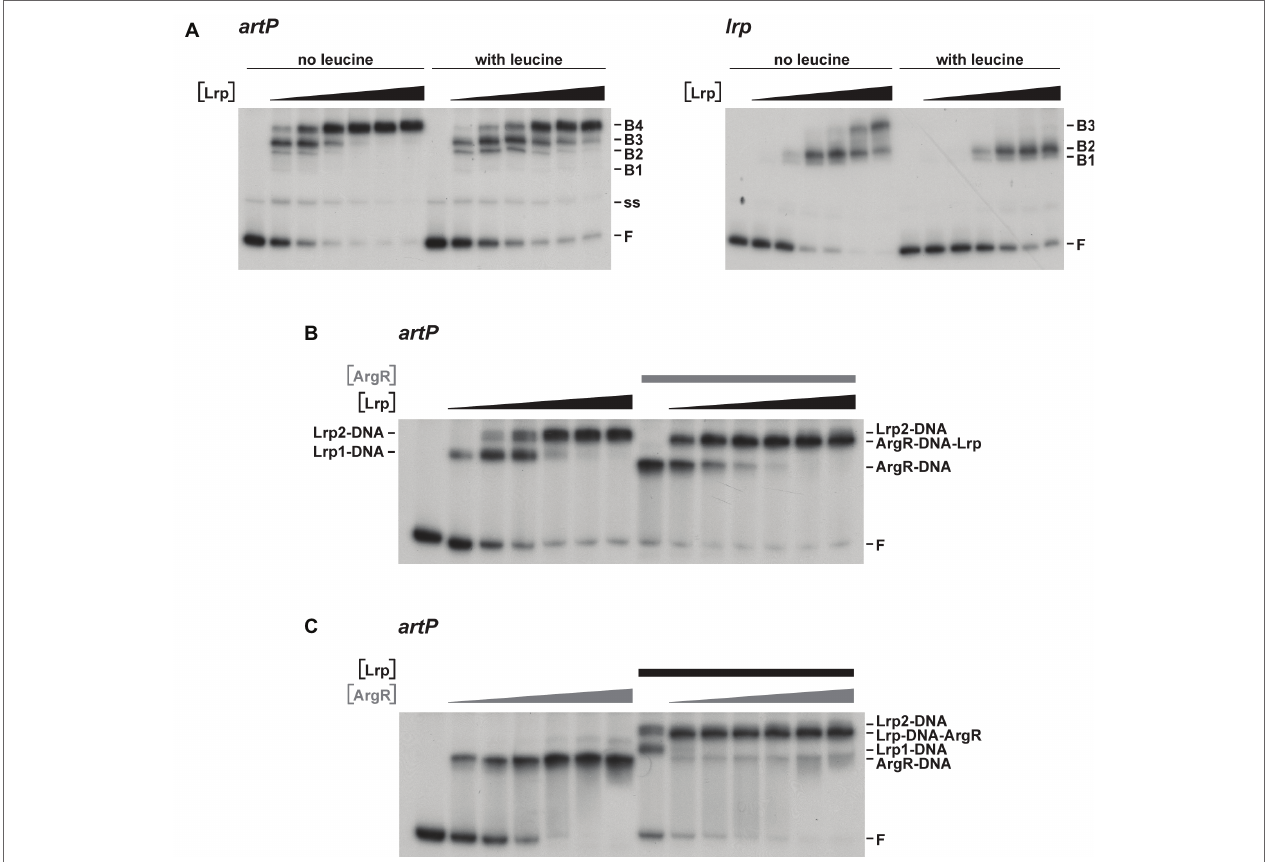
FIGURE 3 | Representative autoradiographs of EMSAs with Lrp and ArgR binding to radiolabeled fragments bearing the artP or lrp control region in the presence of an excess non-labeled non-specific competitor DNA (sonicated harring sperm DNA). (A) Binding of Lrp to the artP and lrp control region in the absence and in the presence of 7.0 mM l -leucine. The position of free DNA (F), single-stranded DNA (ss) and the various Lrp-DNA complexes (B1 to B4) is indicated. The black triangle represents increasing Lrp concentrations corresponding to 0, 0.23, 0.46, 0.92, 1.84, 3.68, and 7.36 μM (expressed in monomer equivalents). (B) Binding of Lrp and Lrp plus ArgR to the artP control region. In the right-hand part of the panel a constant concentration of ArgR (0.48 nM, expressed in hexamer equivalents and indicated with a gray colored bar) was allowed to bind to the artP control region prior to the addition of increasing concentrations of Lrp (0, 0.23, 0.46, 0.92, 1.84, 3.68, and 7.36 μM indicated with a black colored triangle). The left-hand part of the panel represents binding of the same concentrations of Lrp only, as a control (notice that complexes indicated here as Lrp1 and Lrp2 correspond to complexes B3 and B4 of panel A). (C) In the right-hand part of the panel a constant concentration of Lrp (3.04 μM, indicated with a black colored bar) was allowed to bind to the artP control region prior to the addition of increasing concentrations of ArgR (0, 0.48, 0.96, 1.92, 3.84, 7.68, and 15.3 nM as indicated with a gray colored triangle). The left-hand part of the panel represents binding of the same concentrations of ArgR only, as a